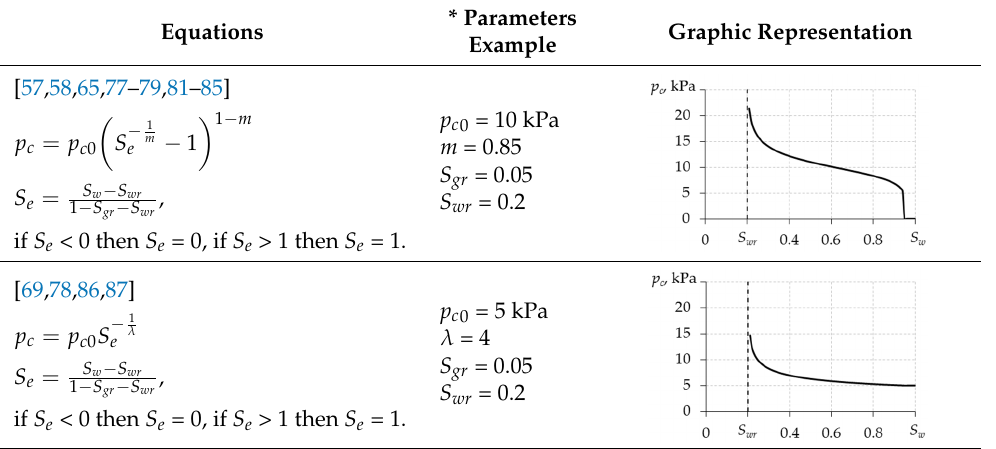
Table 2. Calculation of capillary pressure.